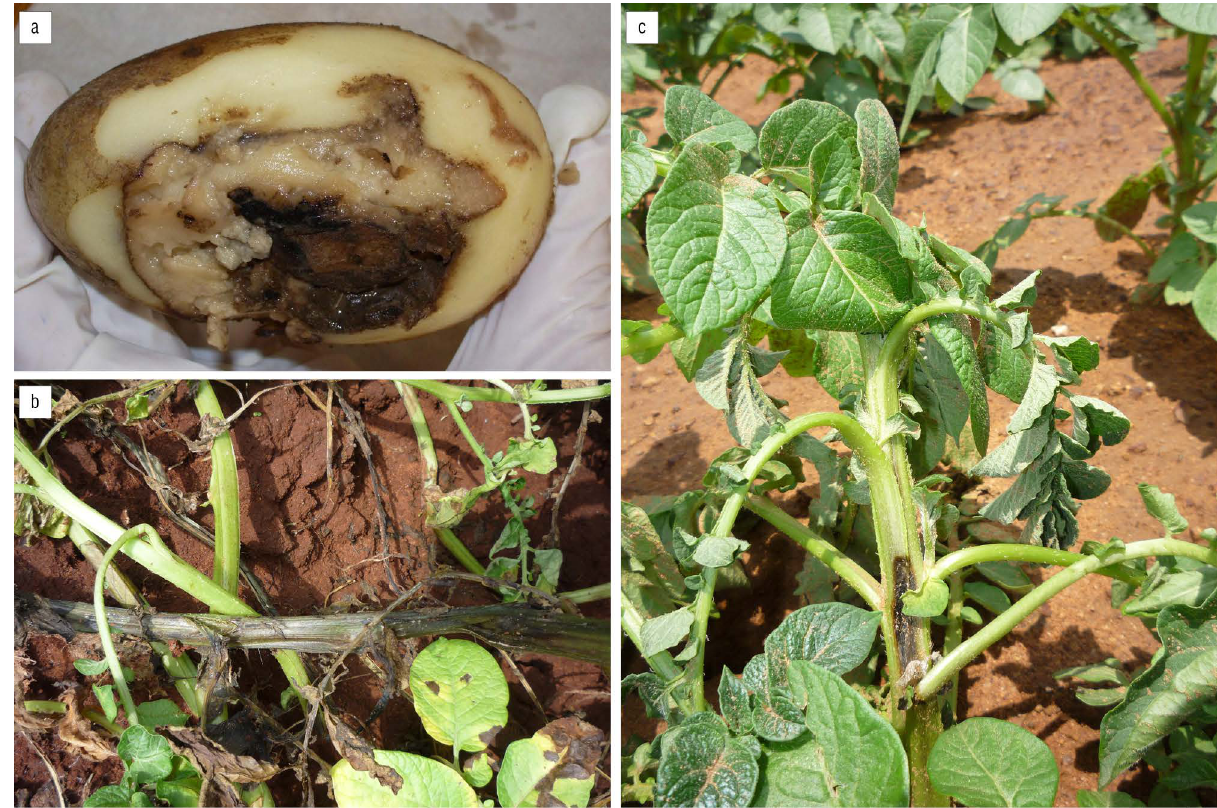
Figure 3: (a) Soft rot of potato tuber. (b) Blackleg of potato plant in field. (c) Early symptoms of aerial stem rot on a potato